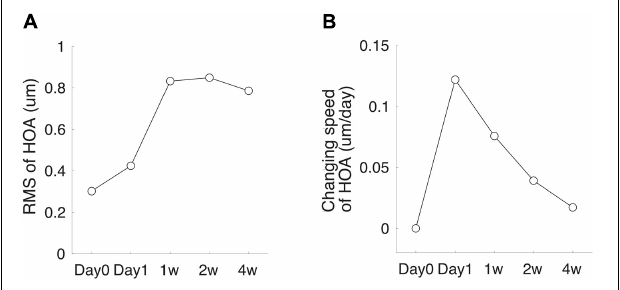
follow-up visit.